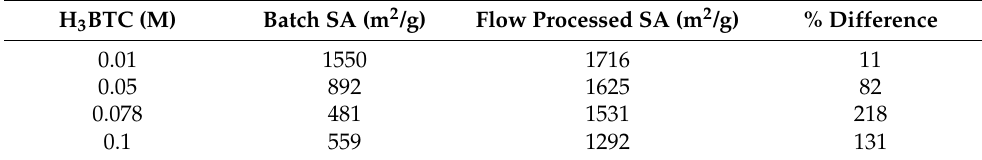
Table 3. Summary of Brunauer–Emmett–Teller (BET) surface areas for electrosynthesis from 0.01 M to 0.1 M H 3 BTC in batch and using flow processing. Percentage difference calculated as a percentage of batch surface area. H 3 BTC